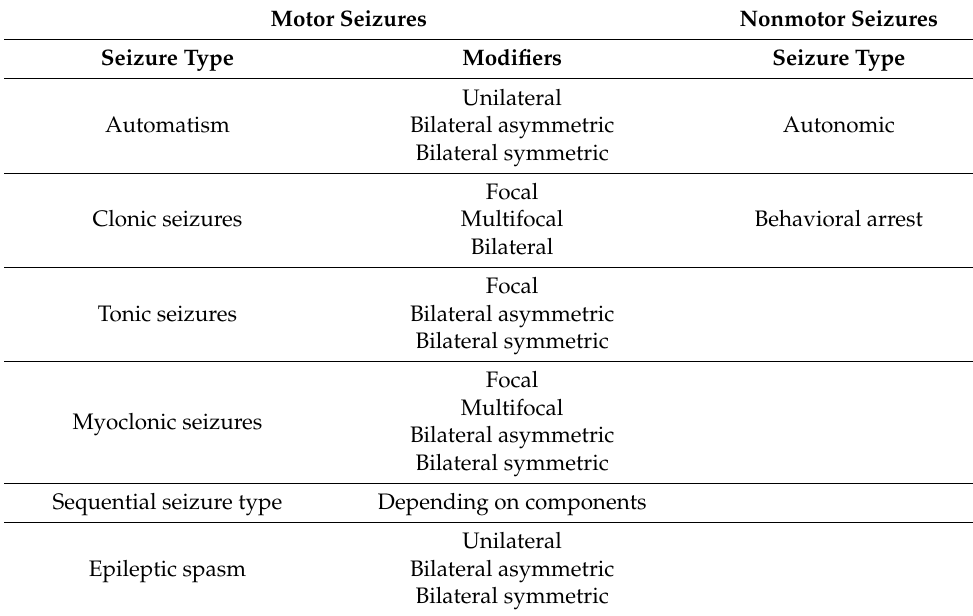
Table 5. Types of neonatal seizures including motor and nonmotor seizures